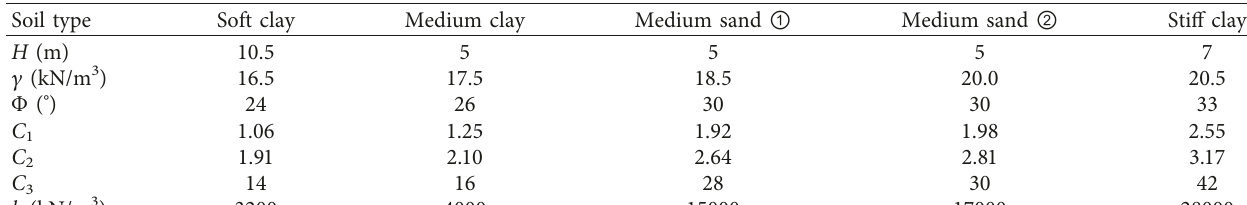
Table 1: Distribution and parameters of soil layers.